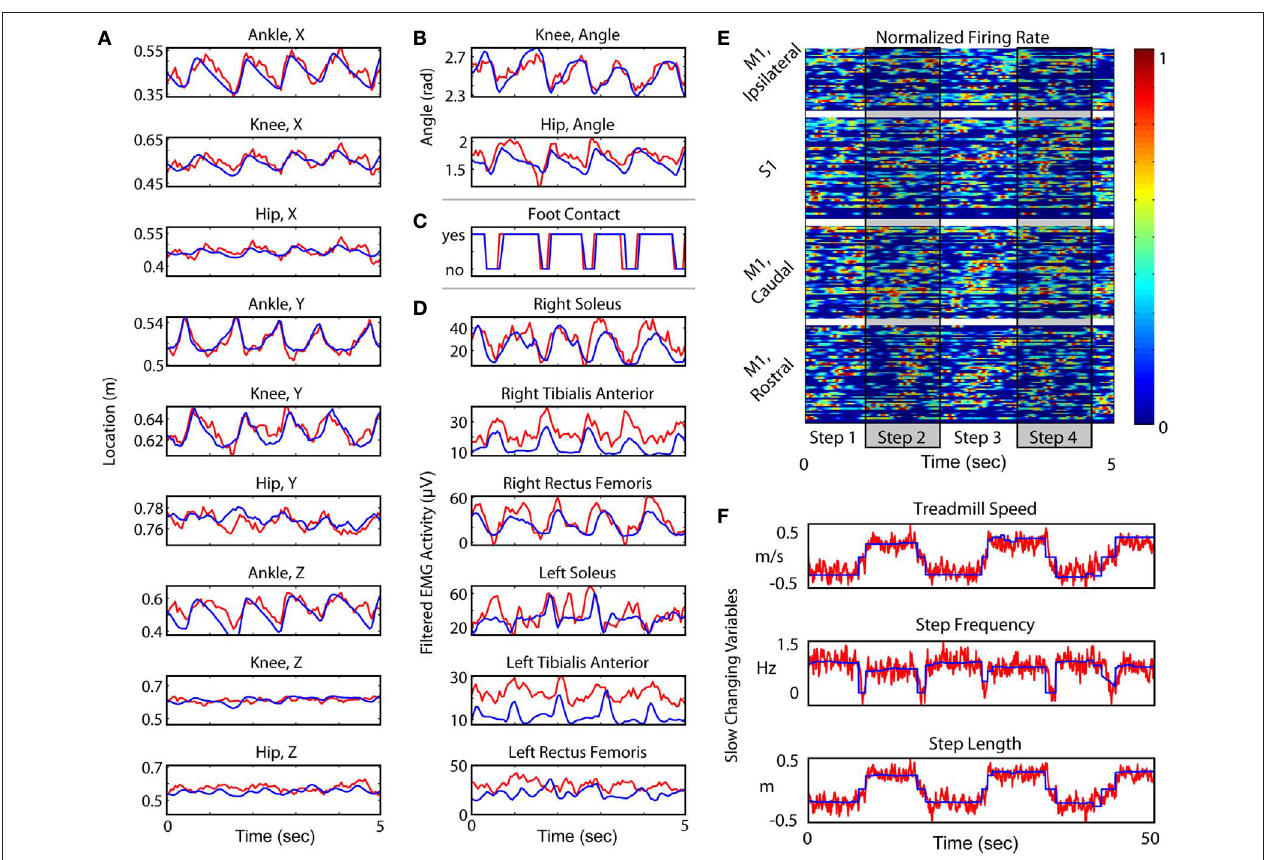
but orthogonal to the direction of motion. (B) Joint angle variables. Hip angle is calculated assuming a fi xed torso. (C) Foot contact, a binary variable defi ning the swing versus stance phase. (D) EMG variables. (E) Neuronal activity of 220 single units sorted via cortical area and by phase within the step cycle. Firing rate is normalized for every unit. (F) Slow changing state variables (walking speed, step frequency and step length) plotted over a 50 s time